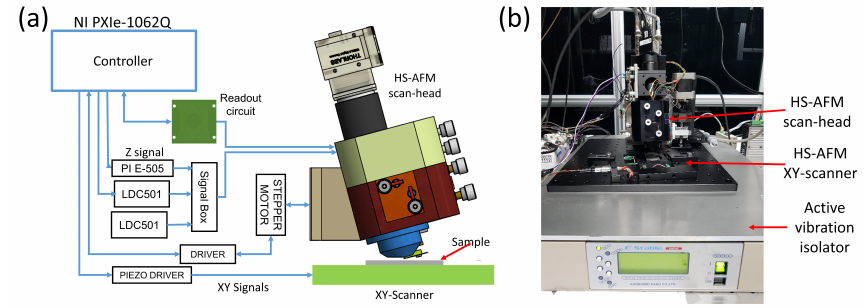
Figure 5. The experimental setup. ( a ) Schematic of the setup; ( b ) Photographs of the setup. To drive the XY-scanner, we used a homemade dual-channel piezo driver with a maximum peak-to-peak output voltage of 290 V and the open-circuit bandwidth of 12